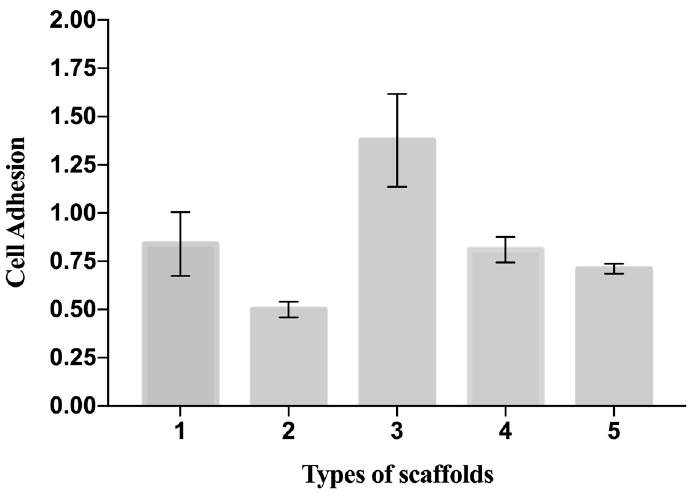
Figure 5. Cell adhesion on the scaffolds measured as ratio number of cells attaching to the scaffold to the number of cells attaching to the well. Data are expressed as the mean ± SD ( p -values < 0.05 is the significance interval).